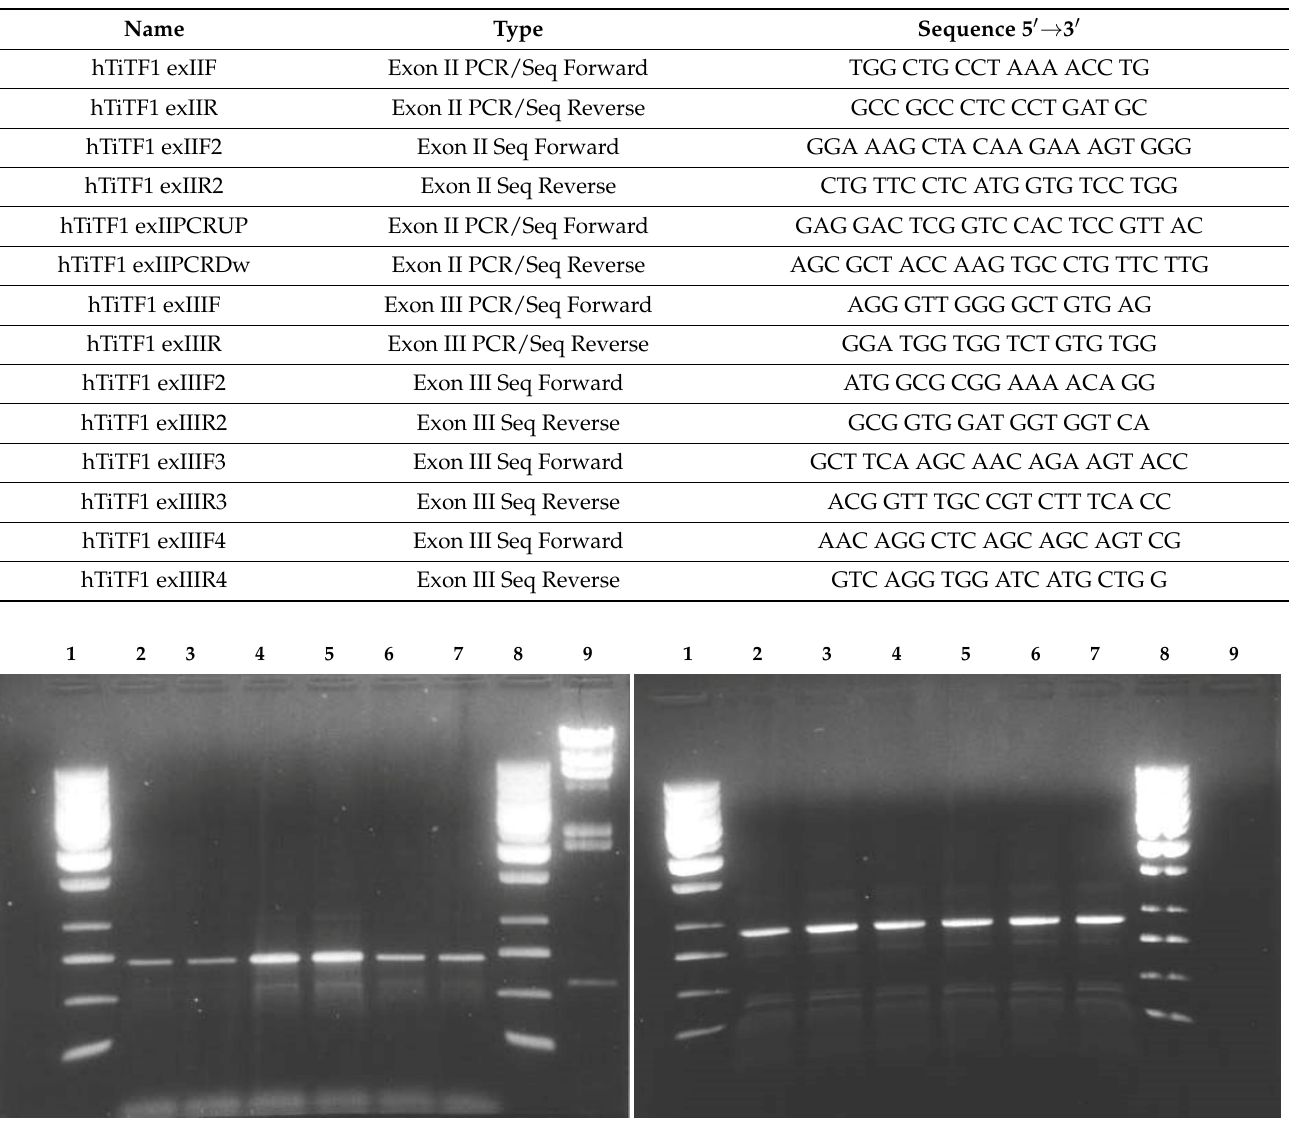
Table 2. Oligonucleotides for PCR and/or sequencing. Figure 1. Exon II and III of TITF1 gene targeted for genetic screening.